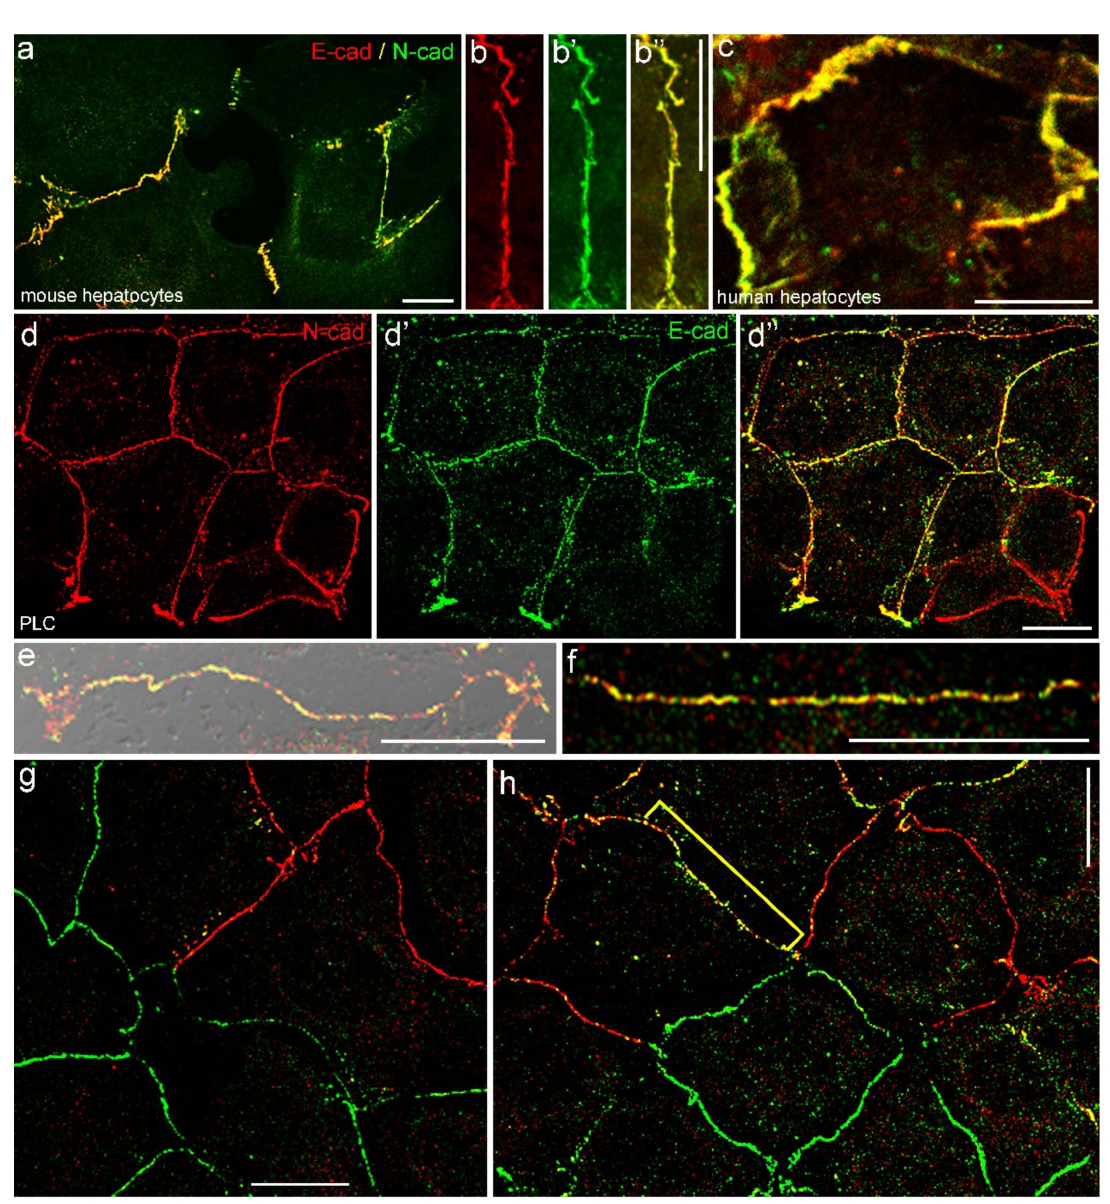
Figure A1. E- and N-cadherin colocalize in primary hepatocytes as well as in HCC-derived cultured cells. In confluently grown primary mouse ( a , b – b (cid:48)(cid:48) ) and human ( c ) hepatocytes, complete colocaliza- tion of E-cadherin (red) with N-cadherin (green) is detected at the cell borders. In the HCC-derived cell culture line PLC, also partial colocalization of E-cadherin (green) and N-cadherin (red) is noted (( d – d (cid:48)(cid:48) ); see also enlarged membrane areas in ( e , f )). Moreover, the also mutually exclusive staining pattern of E- and N-cadherin is detectable ( g ) as well as membrane areas with partial colocalization (( h ); cf. yellow bracket). Bars: 20 µ m